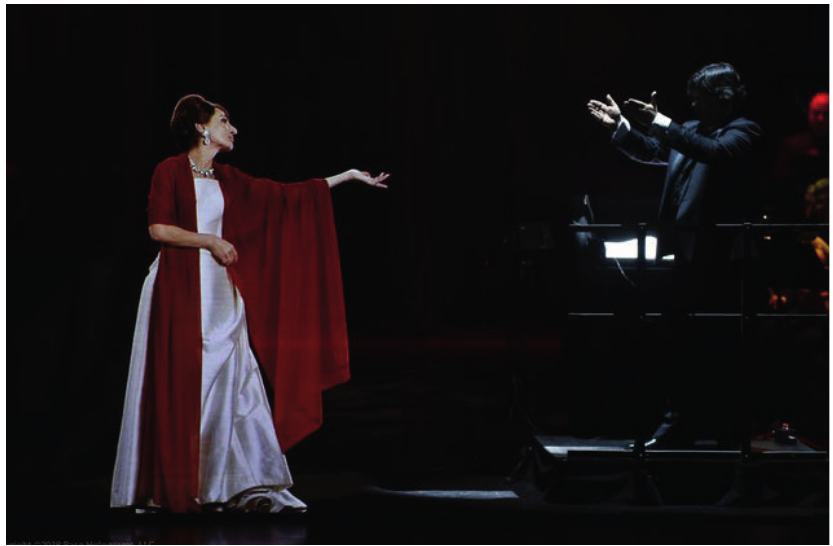
Fig. 3 The hologram of Maria Callas gesturing at the conductor and vice-versa. (©Evan Agostini/Base